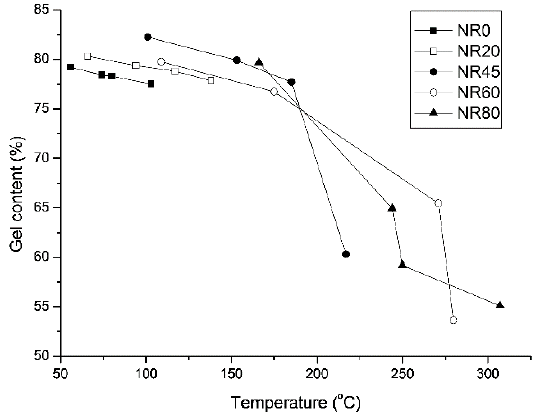
Figure 2. Gel content versus temperature of the samples after exposure to microwaves.